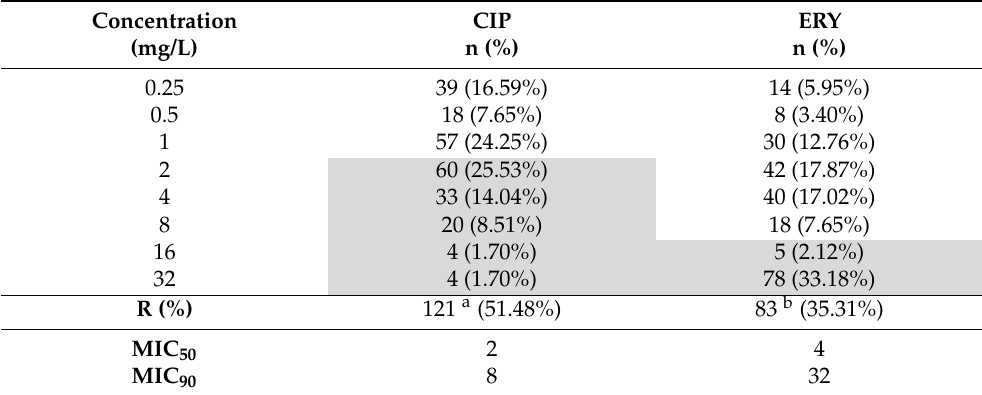
Table 1. Frequency distribution and percentages for the MIC, MIC 50 , and MIC 90 (mg/L) in C. jejuni isolated from chicken carcasses in Brazil.